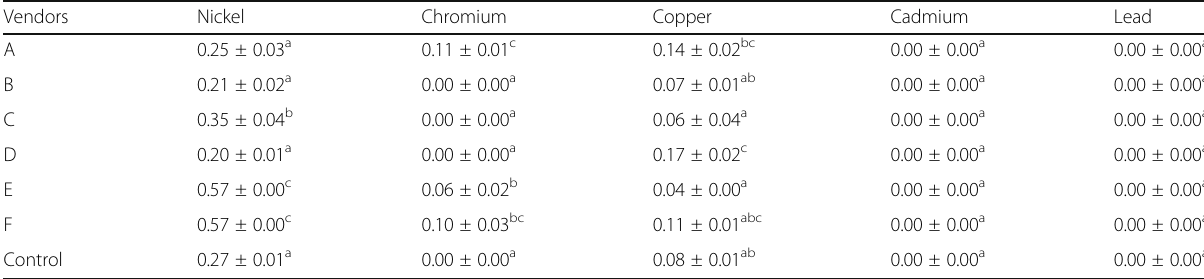
Table 1 Concentration (mg kg − 1 ) of heavy metals in sliced watermelon fruits purchased from Isinkan market Vendors